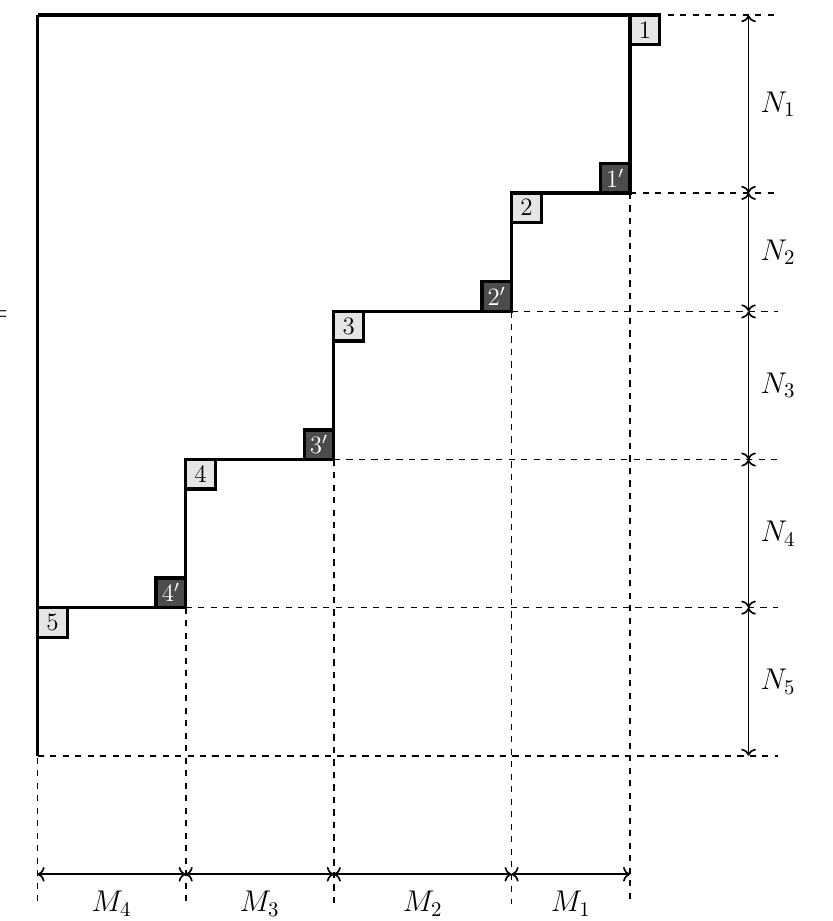
Figure 1 . The general background Young diagram B having a staircase shape, which corresponds to the LLM geometry of concentric shapes by AdS/CFT. All M i and N i are The gray and black boxes represent localized string excitations. To de(cid:12)ne the operation +++ we should choose one gray